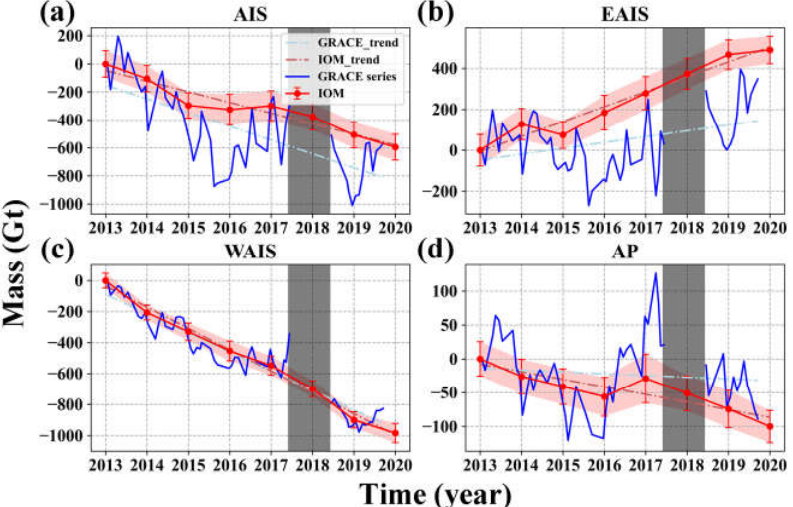
Figure 7. Comparison of our mass balance estimates with Gravity Recovery and Climate Experiment (GRACE) and GRACE Follow-On (FO) mass change estimates for 2013–2020 in ( a ) the AIS, ( b ) the EAIS, ( c ) the WAIS, and ( d ) the AP [10]. The red shaded part in the figure represents the uncertainty range of our calculation, and the red dashed line and light blue dotted line represent the trends of our study’s results and the gravity-based results from 2013 to 2020, respectively. Gray vertical bar indicates the gap between the end of GRACE and the start of GRACE-FO.